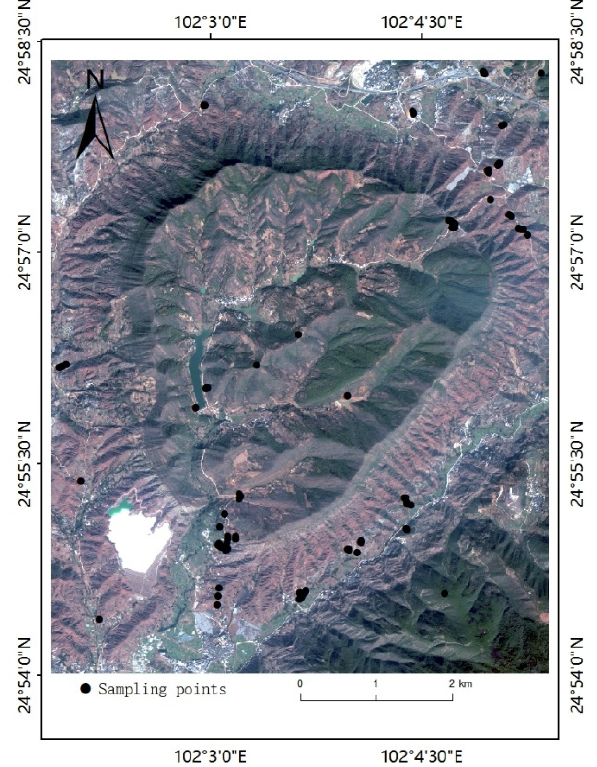
Figure 1. Distribution map of the soil sampling points.